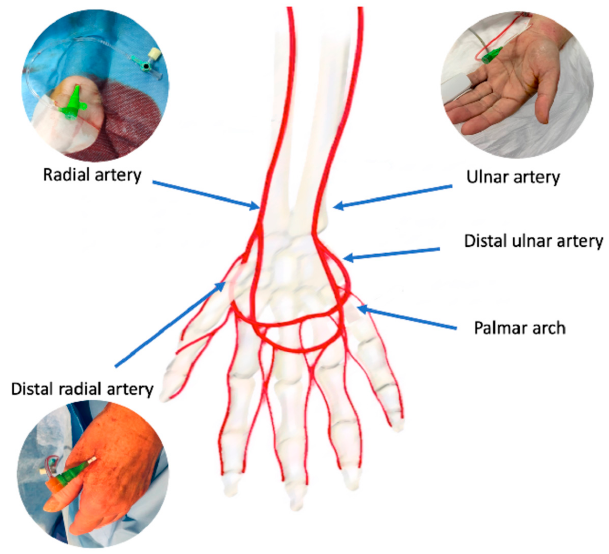
Figure 1. Arterial anatomy of the wrist / hand and potential vascular